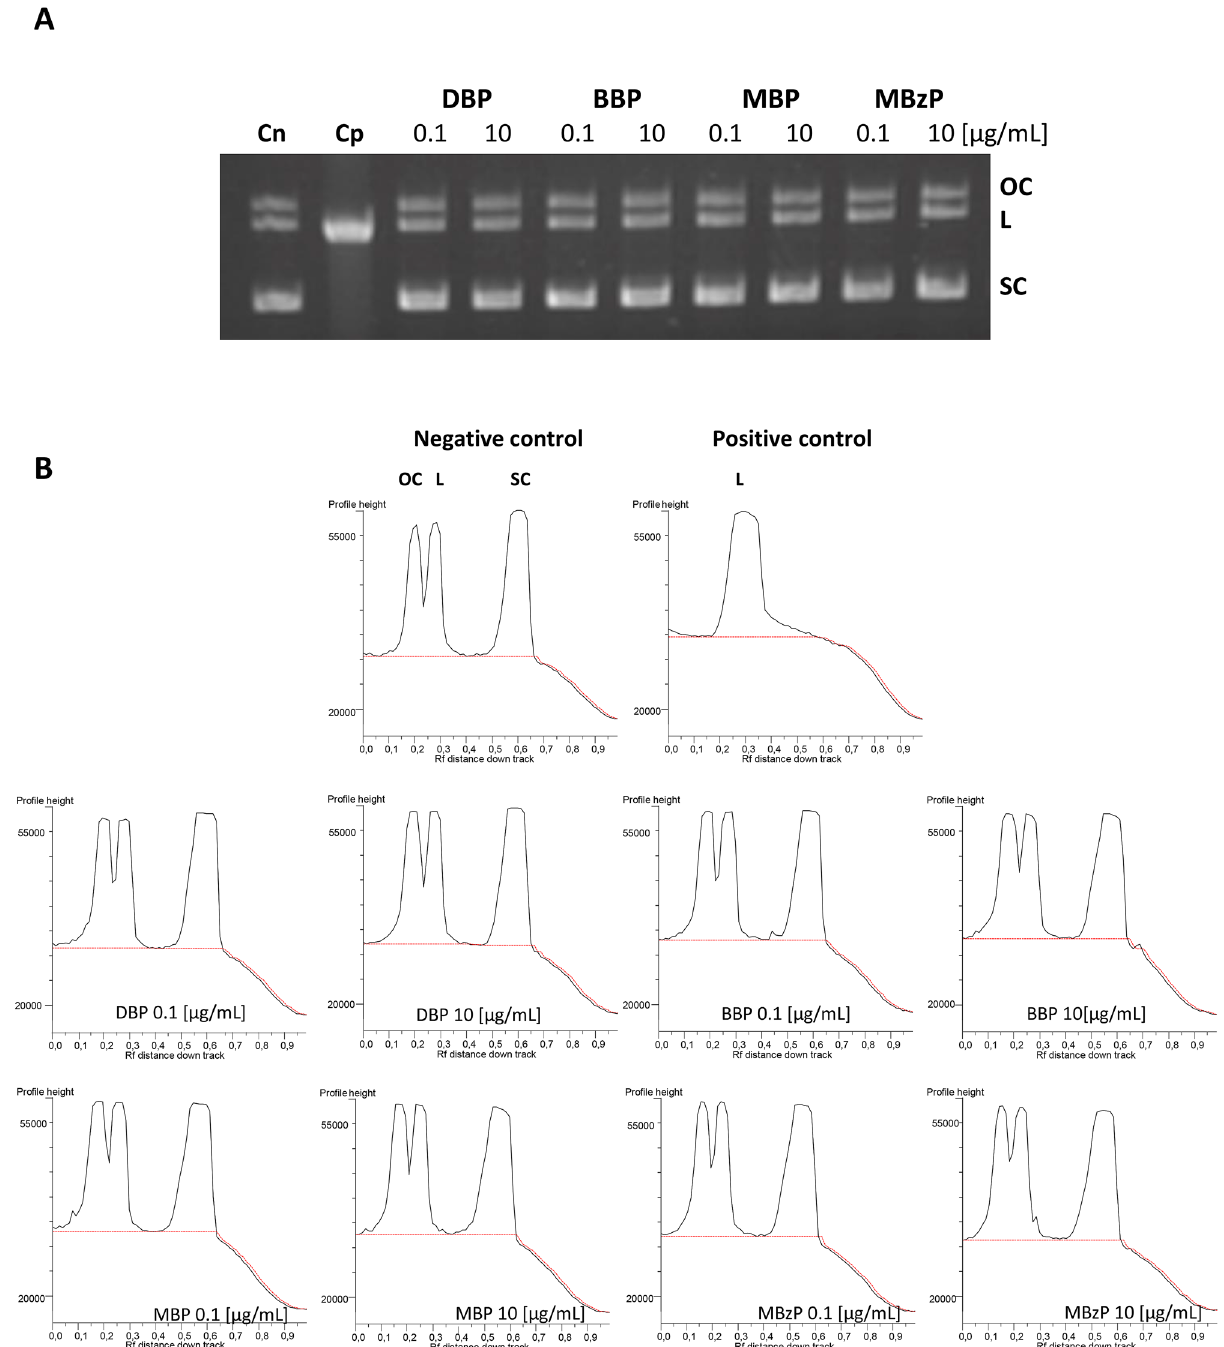
Figure 2. Plasmid relaxation assay. ( A ) pUC19 plasmid DNA was resolved on a 1% agarose gel, stained with ethidium bromide and visualized in UV light. Line 1—negative control (Cn) (pUC19 plasmid); line 2—positive control (Cp) (the plasmid was exposed to 200 µM H 2 O 2 and 20 µM Fe +2 for 20 min on ice, Fenton reaction); lines 3—10 – pUC19 plasmid incubated with DBP, BBP, MBP, MBzP at indicated concentrations. Structural differences between supercoiled (SC), open circular (OC) and linear (L) forms of the plasmid accounted for their different electrophoretic mobility. (B) Densitometric analysis of agarose gel was presented below the gel picture. Open circular (OC) (as a consequence of DNA strand breaks), linear (L) (as a consequence of DNA double strand-breaks) and supercoiled (SC) (undamaged DNA) forms of DNA plasmid are presented as peaks. Densitometric analysis was performed with the GeneTools by Syngene (Cambridge, UK)